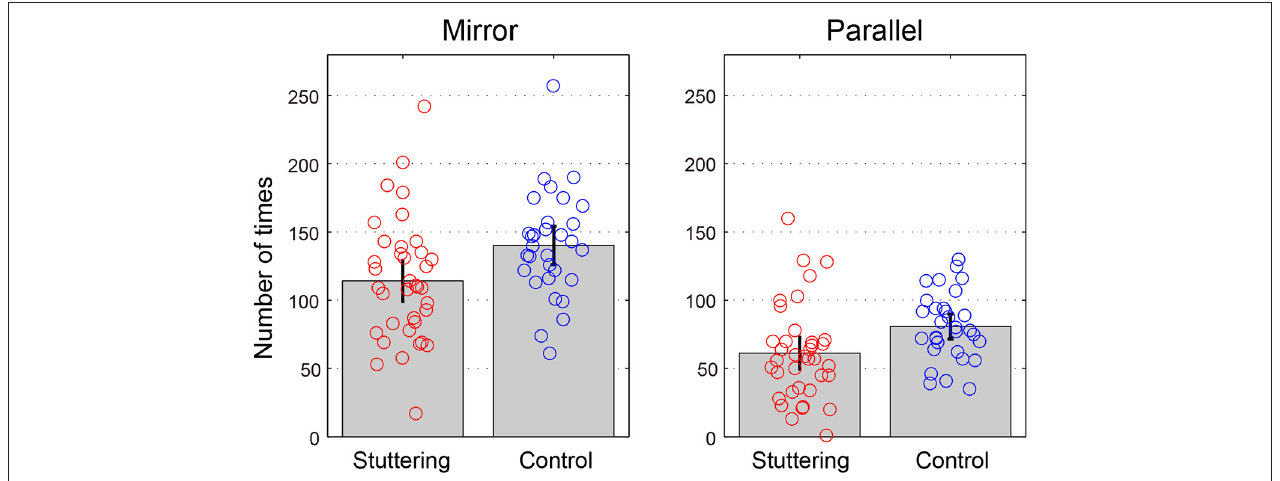
FIGURE 4 | Tapping task. The y-axis represents the number of times performed in 30s for each task. Error bars represent 95% confidence intervals.